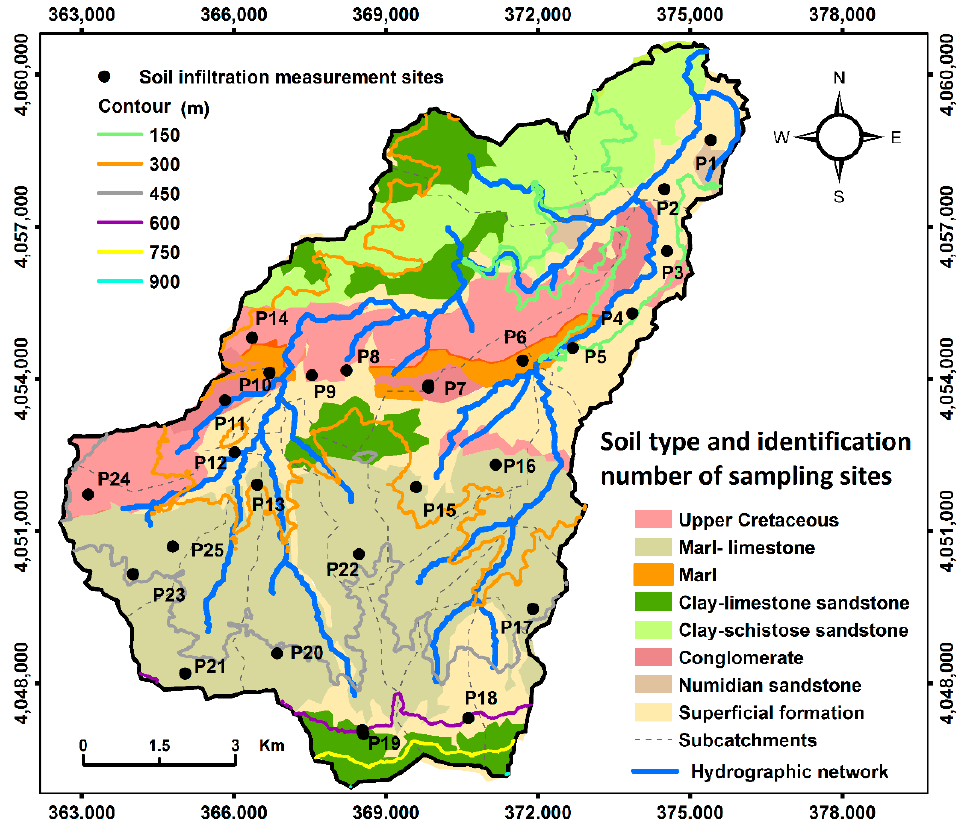
Figure 2. Type of soils and network of measurement points over Madjez Ressoul catchment.